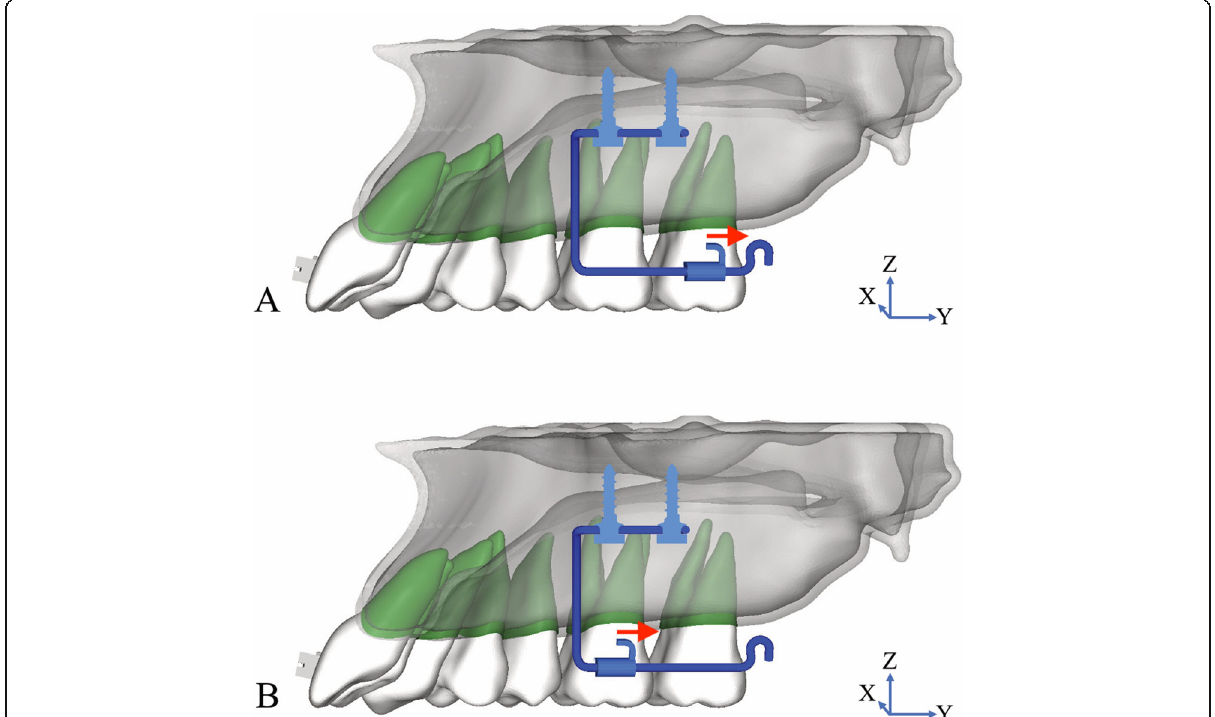
Fig. 2 Applied distalization force parallel to y -axis from the tube of the iPanda on the palatal side to the hook ( a ) one molar distalization ( b ) two molars distalization